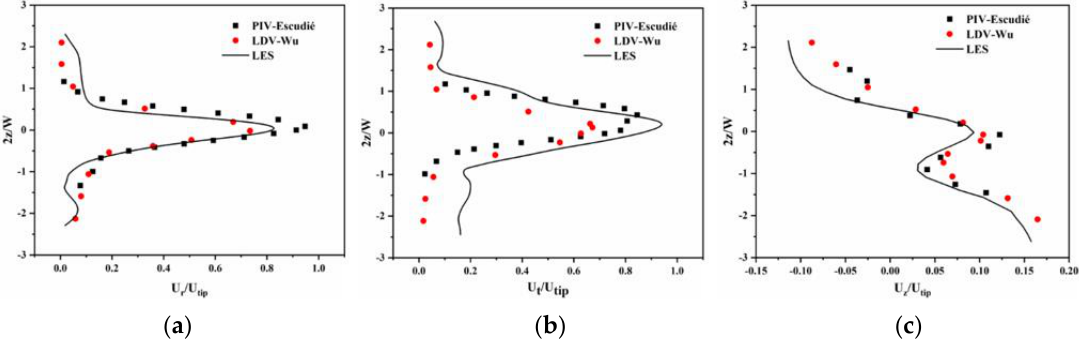
Figure 4. Mean velocity normalized by U tip . ( a ) radial velocity; ( b ) tangential velocity; ( c ) axial